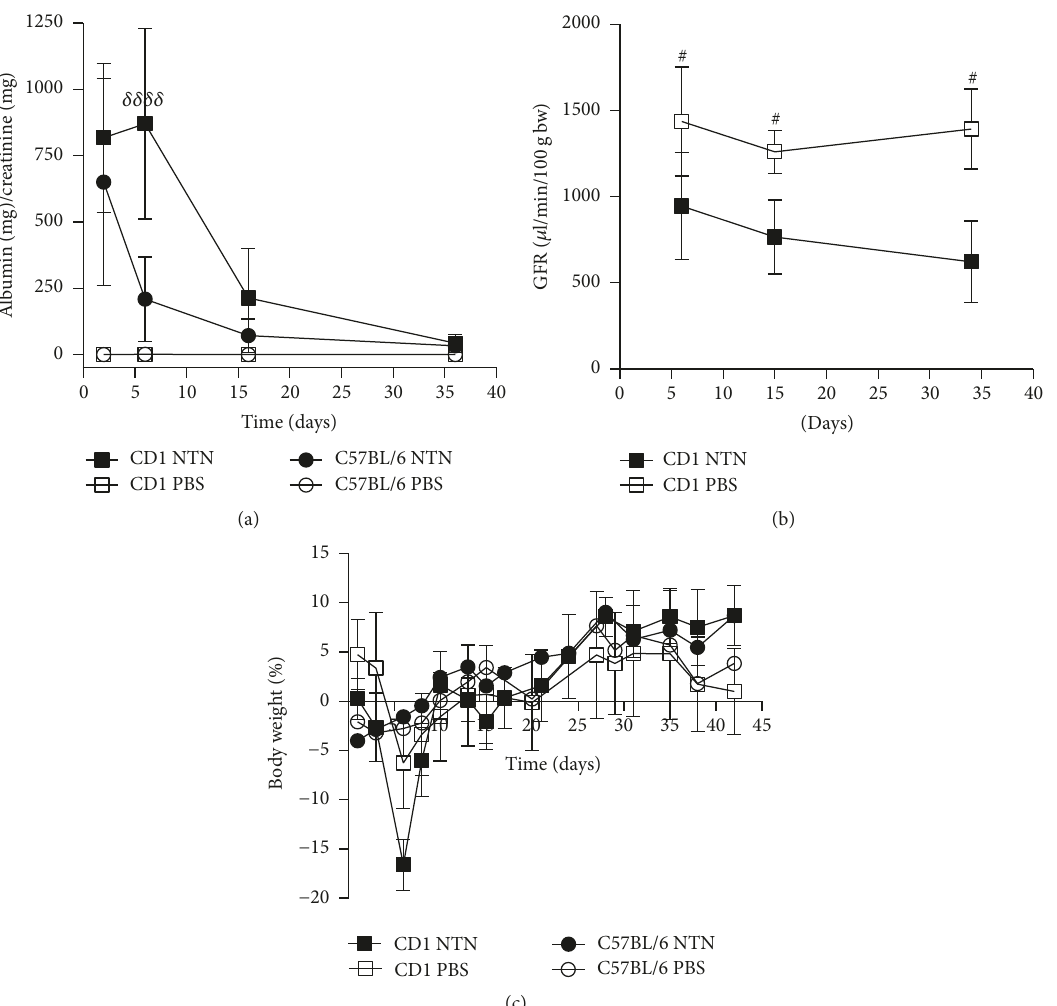
Figure 4: NTS induces albuminuria, GFR decline, and transient weight loss . (a) Graph showing the average urinary albumin/creatine ratio (mg/mg) on days 2-3, 6-7, 16-17, and 36-37. (b) Graph showing the mean glomerular filtration rate ( 𝜇 l/min/100g body weight (bw)) in CD1 mice on days 5-6, 15–17, and 34–37. (c) Graph showing the average percentage change in body weight over time. Data are shown as mean ± SD. # 𝑃 < 0.05 CD1 NTN versus CD1 PBS by one-way ANOVA ( 𝑛 = 10 ); 𝛿𝛿𝛿𝛿 𝑃 < 0.0001 CD1 NTN versus B6 NTN groups by two-way ANOVA ( 𝑛 = 10